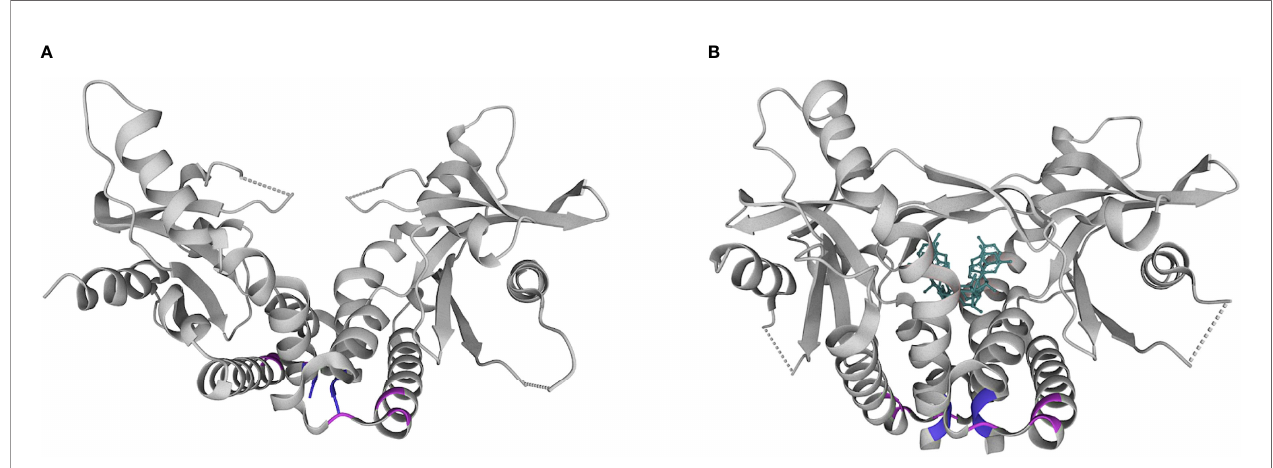
FIGURE 2 | Structural diagram of the STING homodimer in apo (A) and substrate (B) bound forms. cGAMP is shown in teal. Common locations of pathogenic variants associated with SAVI in the dimerization domain (154, 155; purple) and cytosolic domain (279, 281, 284; pink). Pdb structures 4F9E and 4KSY, respectively.